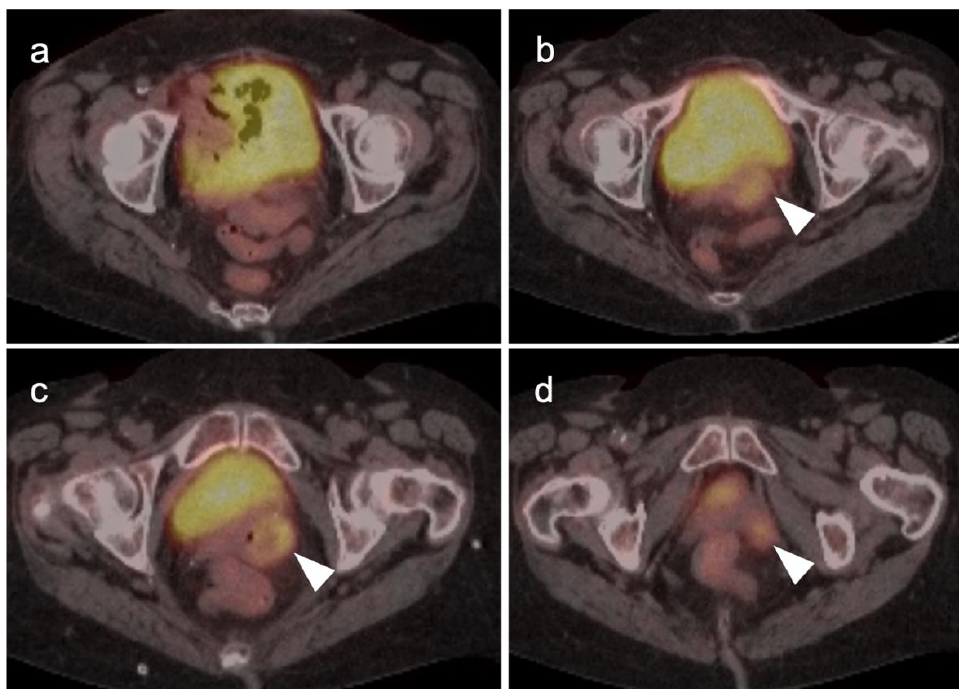
Figure 19. Primary vaginal squamous cell carcinoma on axial FDG PET-CT images of the pelvis. ( a ) shows normal upper pelvic structures; ( b – d ) moderately hypermetabolic mass in the left vaginal apex (white arrowheads).